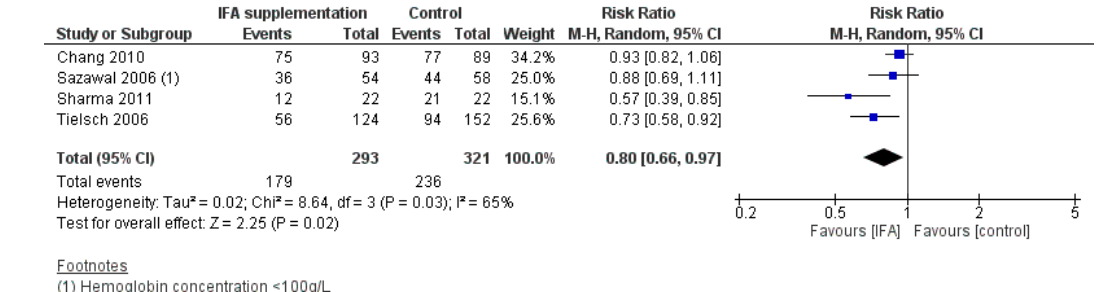
Figure 3. Iron-folic acid supplementation versus placebo/no intervention (efficacy studies) on the risk of anemia (hemoglobin concentration < 110 g/L).